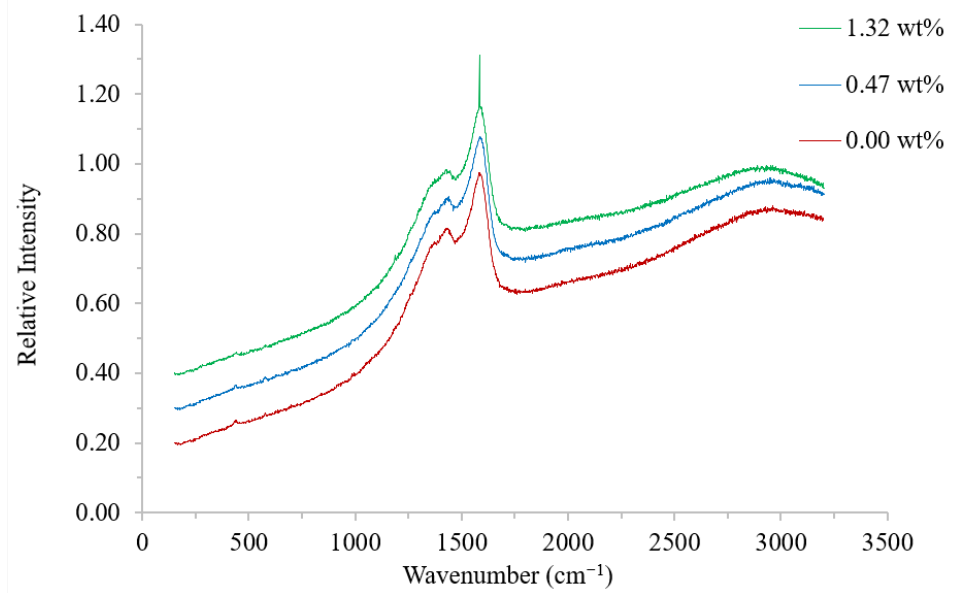
Figure 4. Raman spectra of PEDOT:PSS/Tween 80 films containing 0.00 (red), 0.47 (blue), and 1.32 (green) wt% surfactant (from bottom to top).